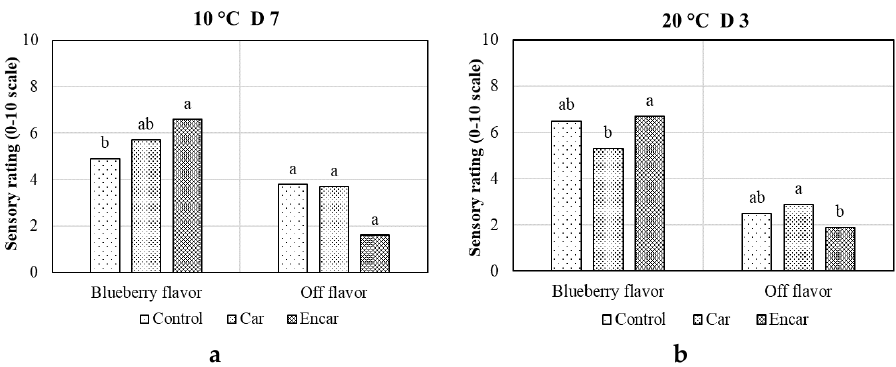
Figure 3. Effects of pectin-sodium alginate microencapsulated carvacrol (Encar) and non-encapsulated carvacrol (Car) on sensory properties of fresh blueberries after 7 days storage at 10 °C ( a ), and 3 days storage at 20 °C ( b ). Bars with different letters indicate significant differences using the Student’s t test ( p < 0.05, n = 10).